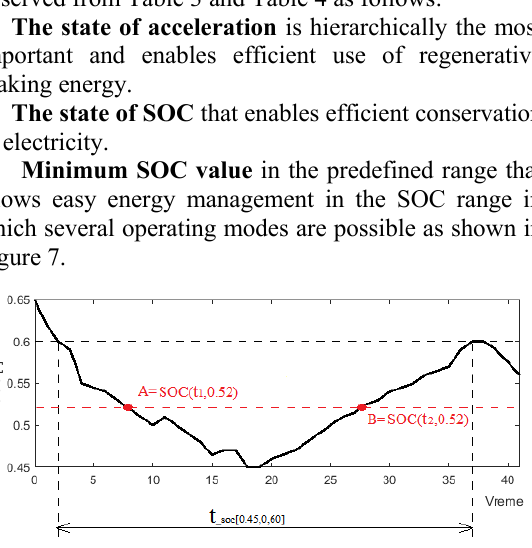
Figure 7. Operating mode selection problem at SOC ∈ (0.45,0.60)